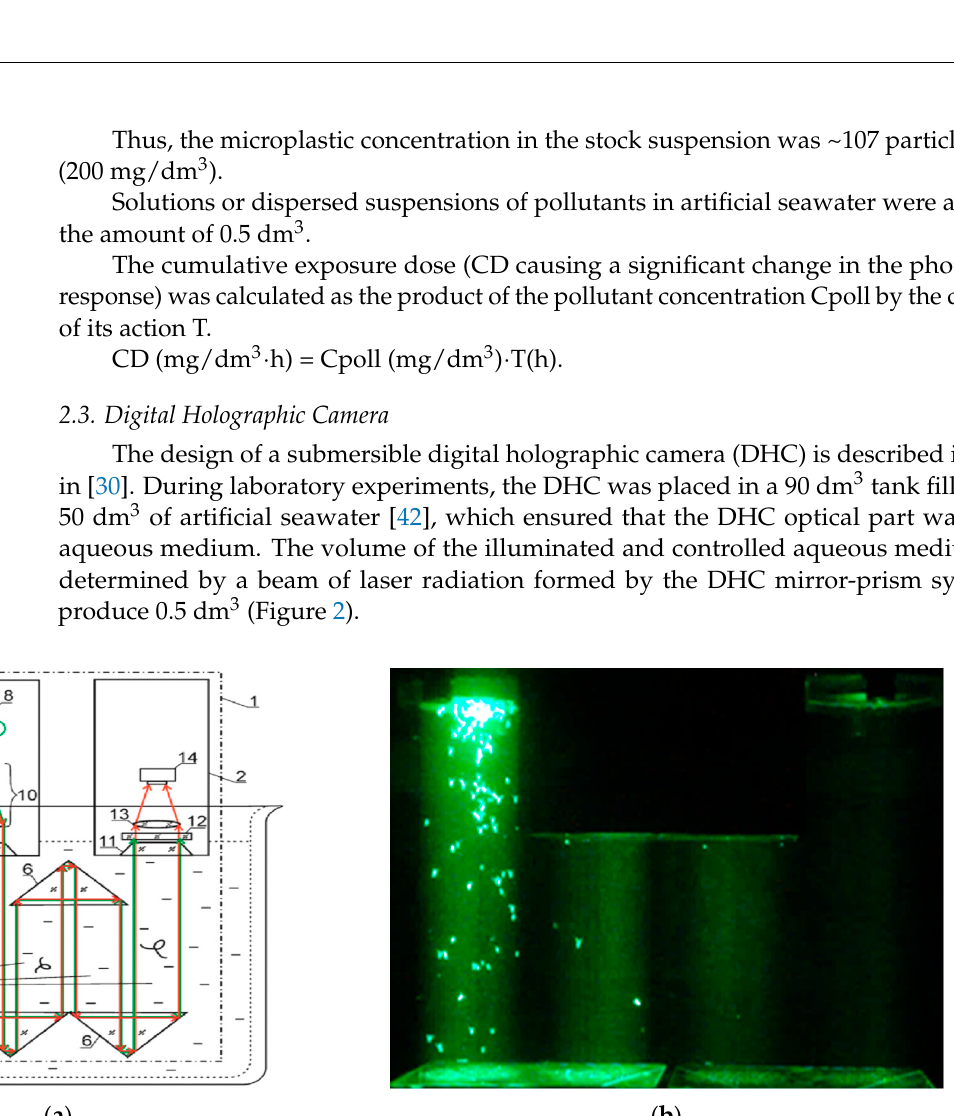
Figure 1. Picture of microplastic particles received using a confocal microscope and ( a ) content of ≤ 10 px and >10 px particles in samples ( b ): ( a ) Microplastic (green) particles are marked with numbers.